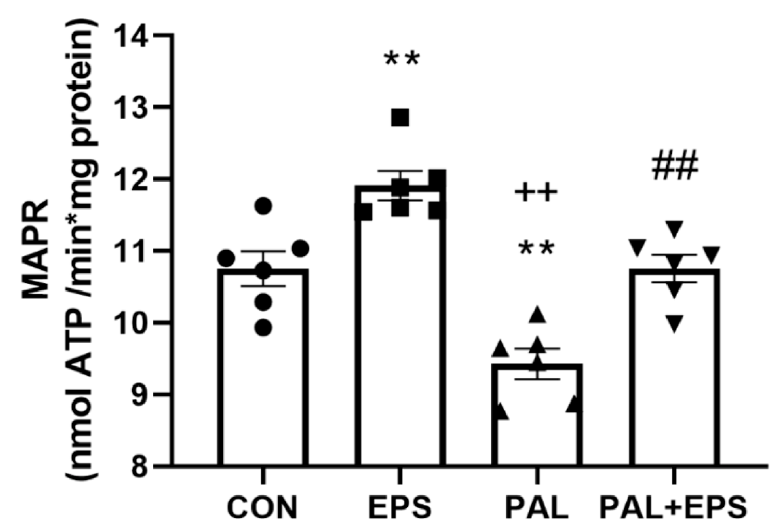
Figure 5. C2C12 myotube maximal mitochondrial ATP production rates (MAPR) from pyruvate + malate after exposure to either standard growth media (CON), 16 h of electrical pulse stimulation (EPS; 11.5 V, 1 Hz, 2 ms), 300 μ M palmitate (PAL) or the combination of both interventions (PAL + EPS). Significantly different from control (CON, ** p < 0.01). Significantly different from palmitate (PAL, ## p < 0.01). Significantly different from EPS ( ++ p < 0.05). Data represent mean ± SEM of 6